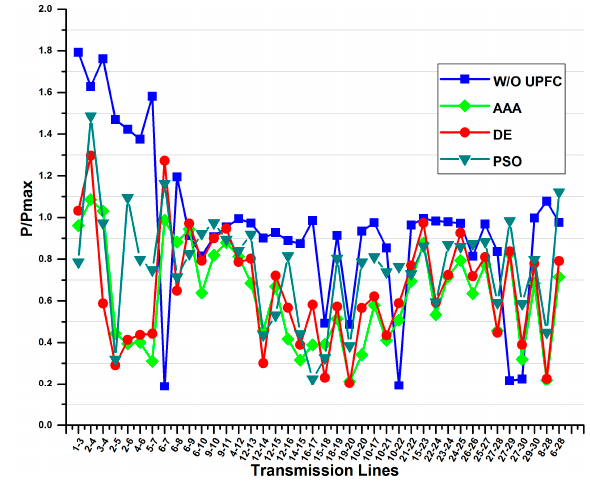
Figure 8. Power Flow distribution for Case Study-2 by AAA, D.E and PSO when line 1 is trip.